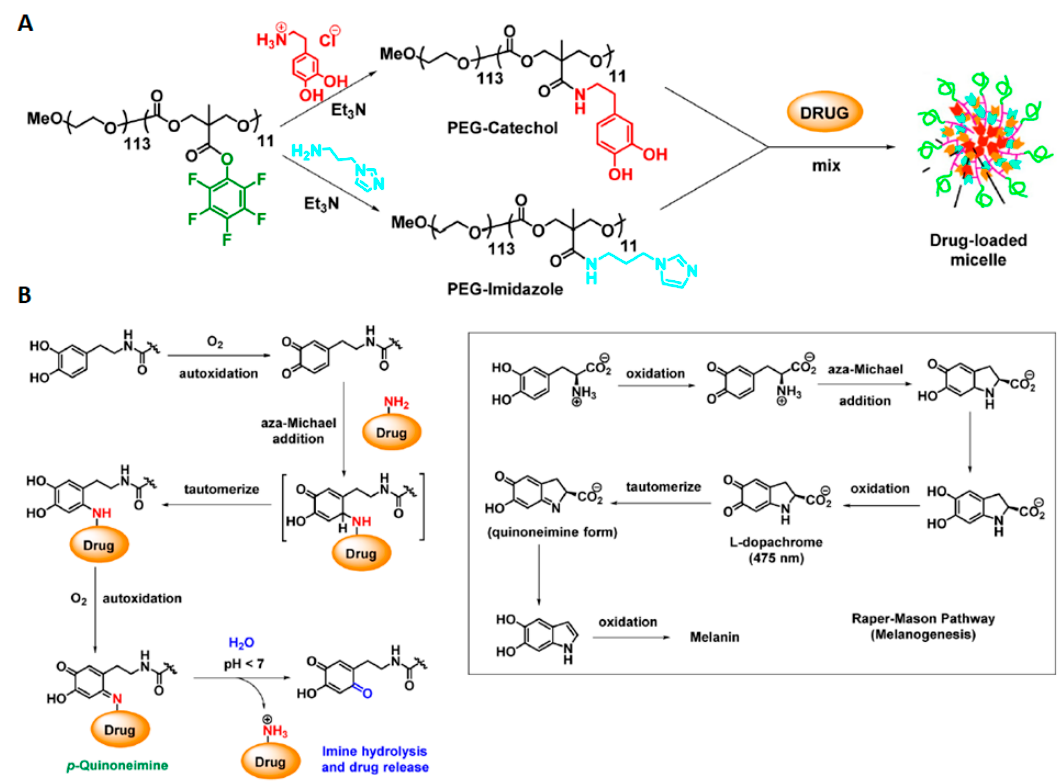
Figure 3. Schematic illustration of preparing ( A ) mixed micelle system based on PEGylated polycarbonate copolymers; organocatalytic anticancer drug loading. ( B ) Biomimetic mechanism of drug-loading onto the catechol side chains of the block copolymer. (inset) Raper − Mason mechanism of melanin biosynthesis. Reprinted with permission from ref [85]. Copyright 2016 American Chemical Society.